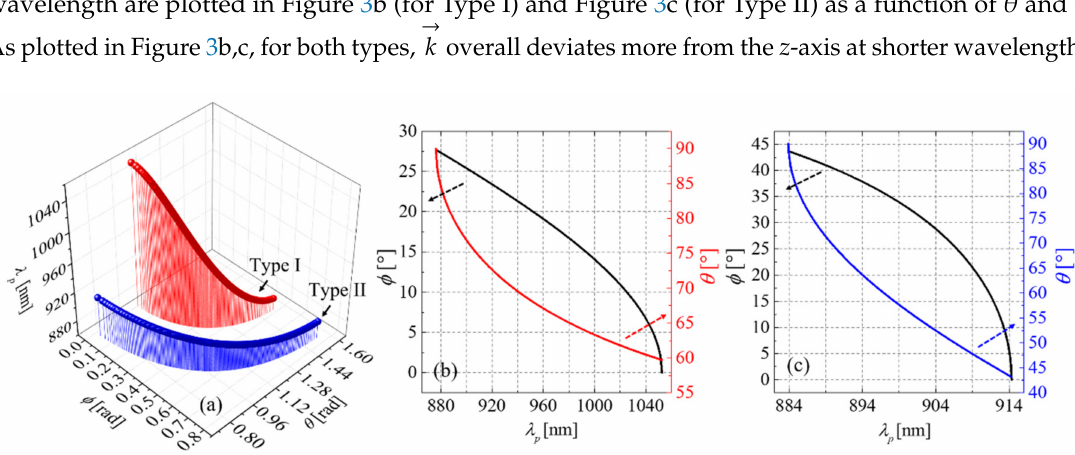
Figure 3. ( a ) Variation of the resonance pump wavelength ( λ p ) satisfying each type of EPM while sweeping the k in space. The k -directions for a given EPM pump wavelength plotted as a function of θ and φ : ( b ) Type I, ( c ) Type